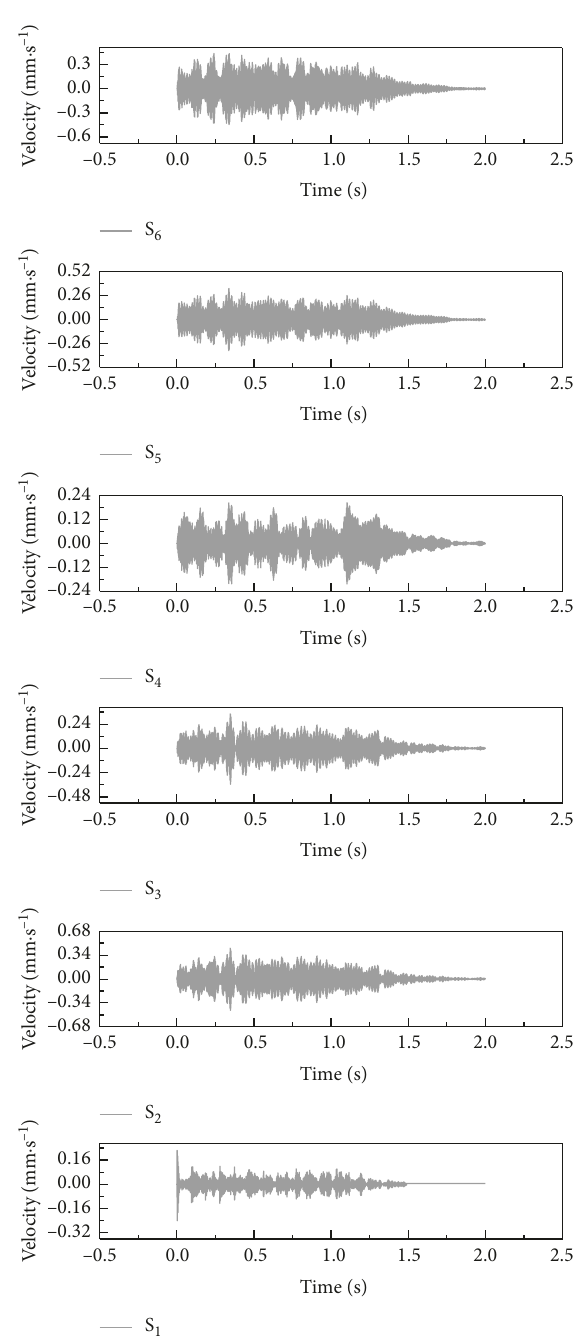
Figure 6: Track slab dynamic response at 10% faulty CAM